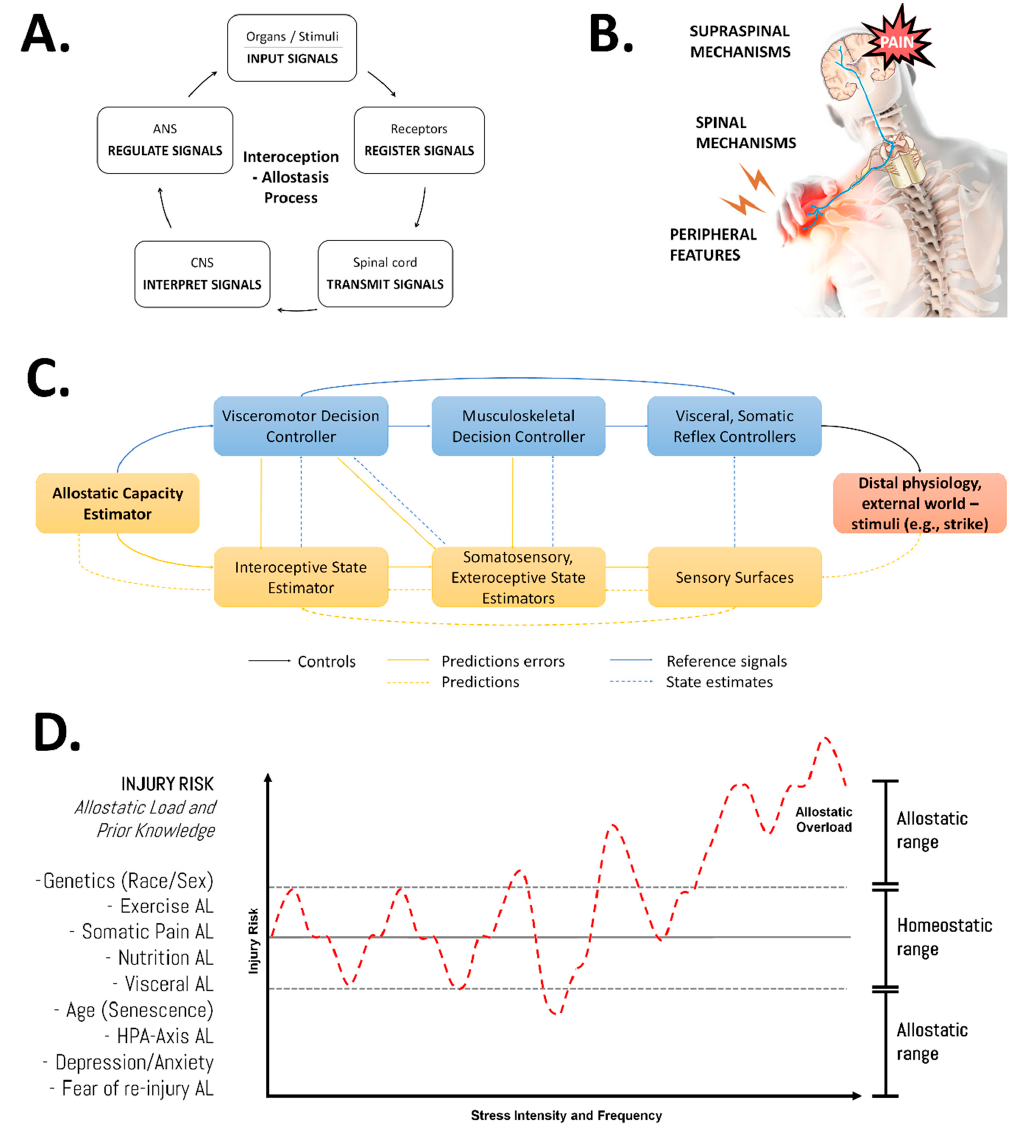
Figure 2. An integrative view of the multifactorial nature of injury risk. ( A ) General features of the interoception–allostasis process. While allostasis represents the adaptive process of stability through change, interoception refers to encoding representations of the internal (physiological) state of the body [86]. ( B ) Modulation of endogenous pain. Nociplastic pain conditions include the combination of central and peripheral pain sensitization, hyper-responsiveness to painful and non-painful sensory stimuli, and associated features (fatigue, sleep, and cognitive disturbances) [87]. ( C ) Detailed representation of the interoceptive–allostatic control (as a closed-loop system) of the human body in response to any stimuli. The injury or pain etiology might be discussed in terms of the role of the input signal (stimuli—distal physiology or external world), receptors (sensory surfaces, biological receptors), transmitters (spinal cord, anatomy trains), decoders (central nervous system), regulator elements (autonomic nervous system), and output signal (response, physiological effects). This block diagram was taken from Sennesh et al. (2022) [88]. ( D ) Representation of the changes in injury risk in response to stress exposition. Importantly, exercise selection is one of the many factors that might impact the allostatic load in fitness practitioners; therefore, it might influence the musculoskeletal or connective tissue overload. However, several other variables should be considered to avoid the risk of injury in PFC. AL: allostatic load. Source: designed by the authors